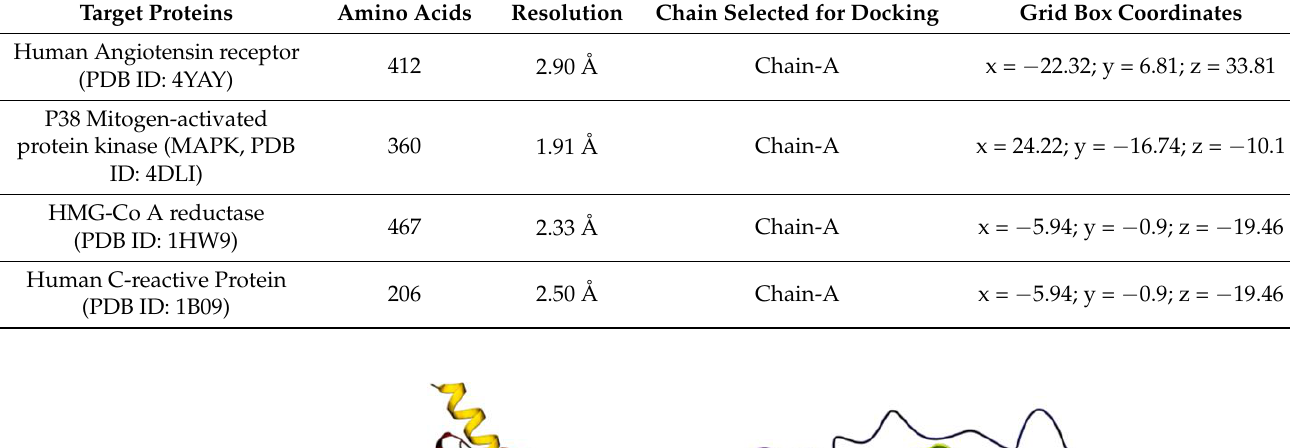
Table 4. Details of target proteins and grid box coordinates for docking.